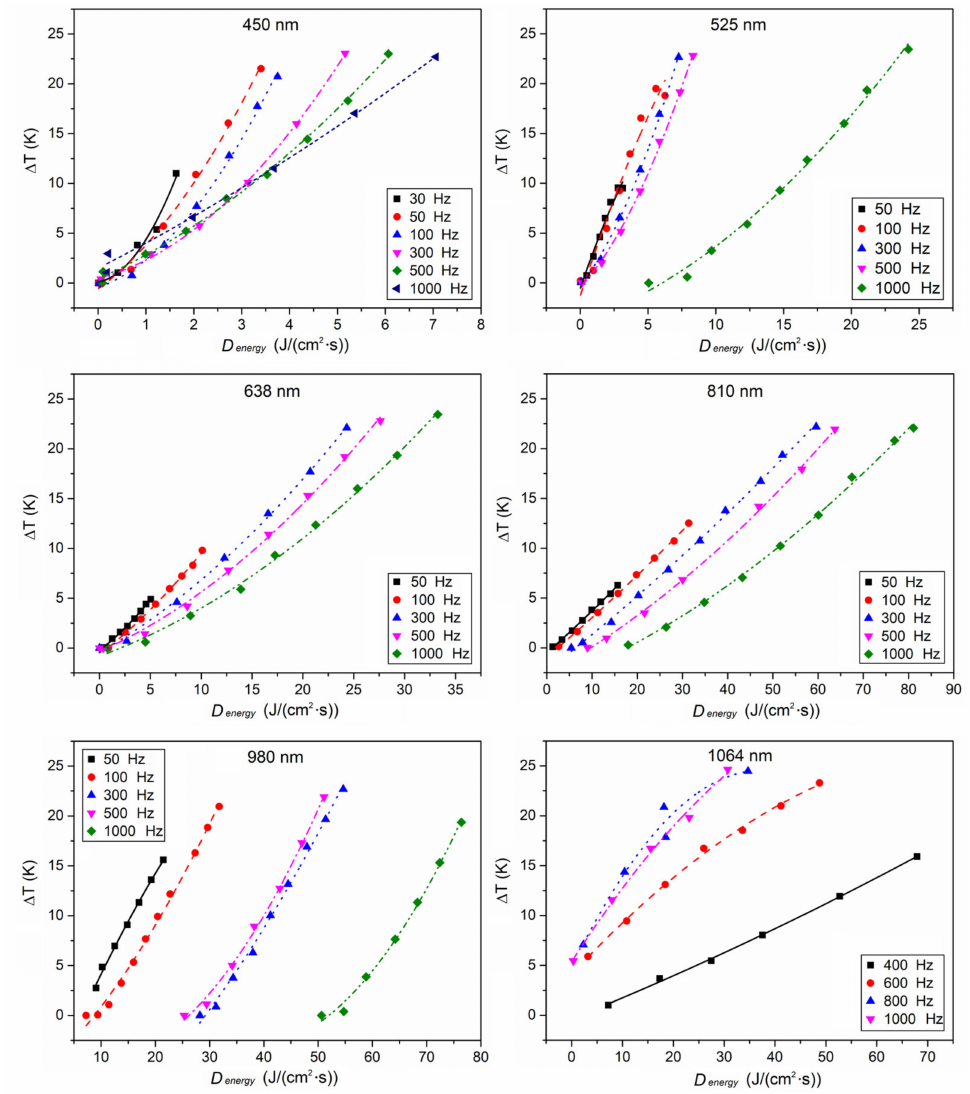
Figure 5. The relationship between the temperature rise ( ∆ T) resulting from the photothermal effect of laser–Pd/Cr thermocouple interactions and the average energy density as well as pulse frequencies for lasers with different